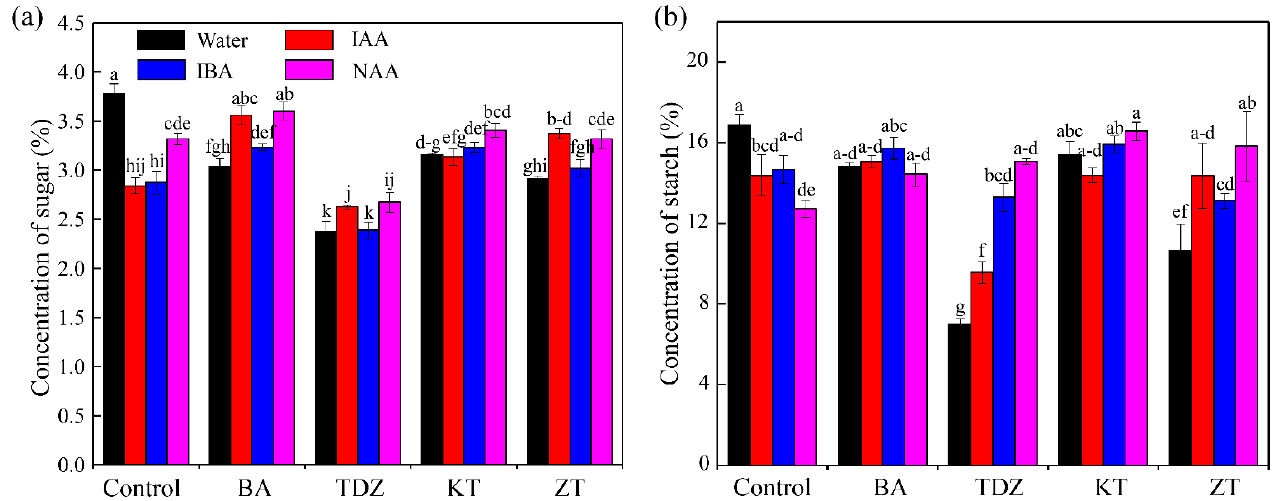
Figure 3. The effect of cytokinin and auxin on soluble sugar ( a ) and starch ( b ) contents in strawberry. Lowercase letters indicate significant differences calculated by Duncan’s multiple range test at p ≤ 0.05. Vertical bars indicate the standard error ( n = 3).